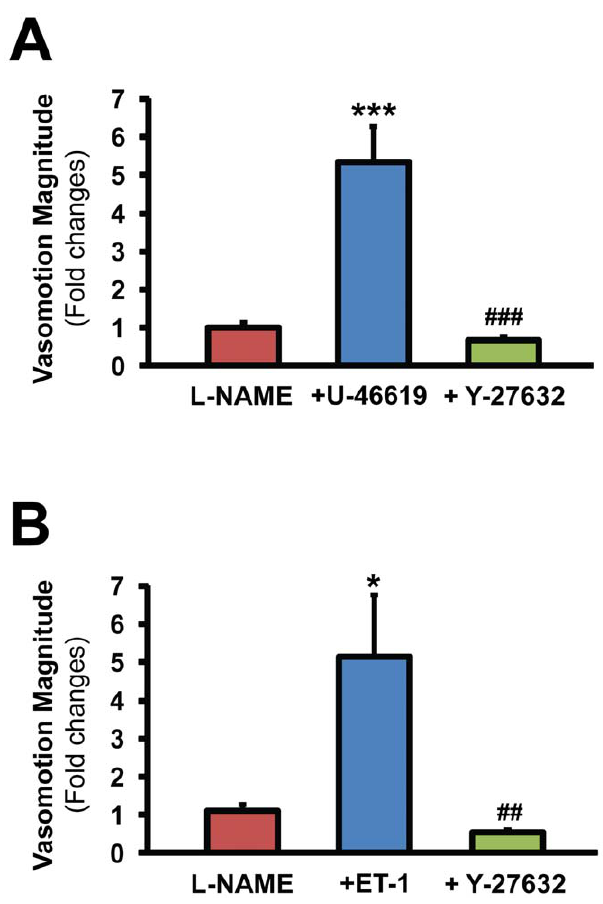
Figure 3. Activation of thromboxane or endothelin receptors induce Rho-kinase dependent vasomotion in NO synthase blocked MCAs. Quantitative analysis of slow wave oscillations with discrete Fourier transformation in L-NAME treated vessels before and after the administration of the TP-receptor agonist U-46619 (Panel A) or endothelin-1 (Panel B) followed by the Rho-kinase inhibitor Y-27632. Values are mean 6 SEM fold changes of the peak magnitudes of the power spectra compared to the baseline. *p , 0.05, ***p , 0.001 vs. L- NAME, ## , 0.01 vs. ET-1 and ### , 0.001 vs. U-46619 (n=10–20).